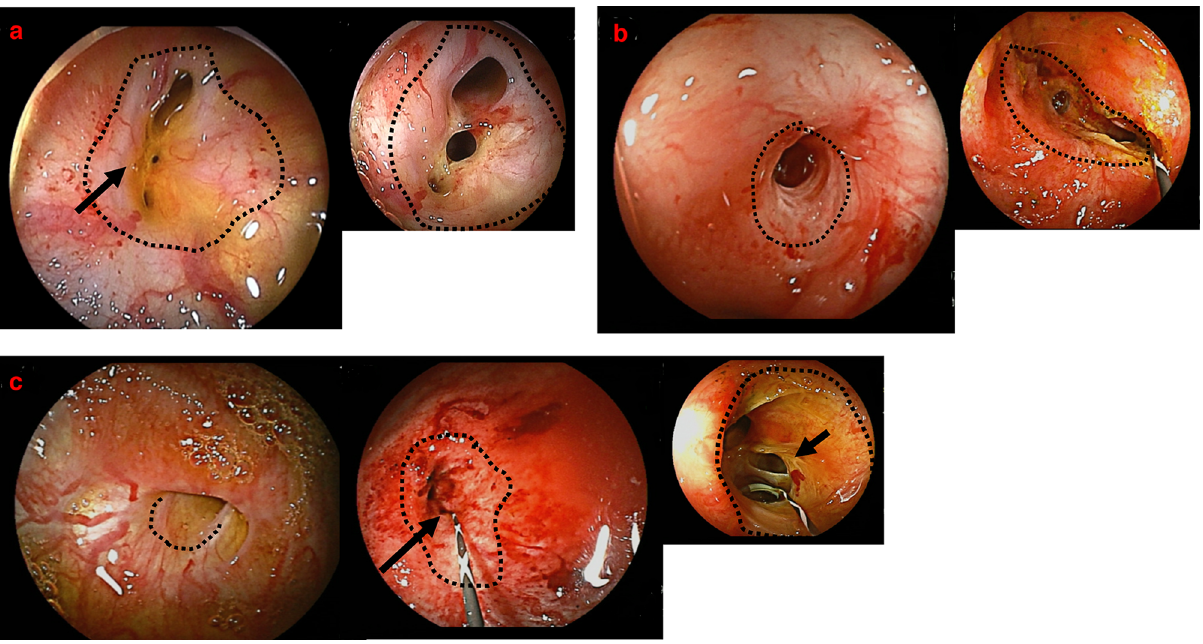
Figure 3. ( a ) Strictures diagnosed as “bile duct strictures.” No strictures at the anastomosis (dotted line) and bile duct mucosa (arrow) are found between the stenotic and anastomotic regions. The figure on the right shows the bile duct after balloon dilatation of strictures (narrowed bile duct) with DBERC. ( b ) Stricture diagnosed as an “anastomotic stricture.” The site of anastomosis is indicated with a dotted line. There is no bile duct mucosa between the stenotic and anastomotic regions. The figure on the right shows the bile duct after balloon dilation of the stenotic anastomosis. There are no strictures at the bile duct. ( c ) Strictures diagnosed as “anastomotic and bile duct strictures.” The anastomosis site is indicated with a dotted line. There is no bile duct mucosa between the stenotic and anastomotic regions. The stricture was diagnosed as an “anastomotic stricture.” The figure in the middle shows the bile duct after dilation of the anastomosis, bile duct strictures (arrow) are also seen. The figure on the right shows the bile duct after balloon dilation of the narrowed segment of the bile duct (arrow). DBERC double-balloon endoscopic retrograde